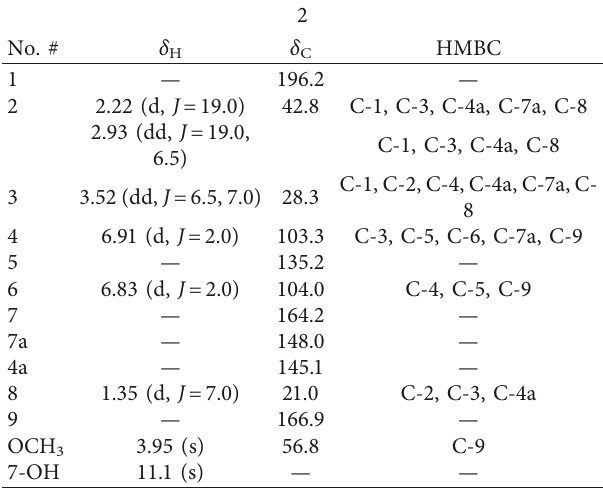
Table 2: 1 H, 13 C NMR, and HMBC spectroscopic data of com- pound 2 (DMSO).